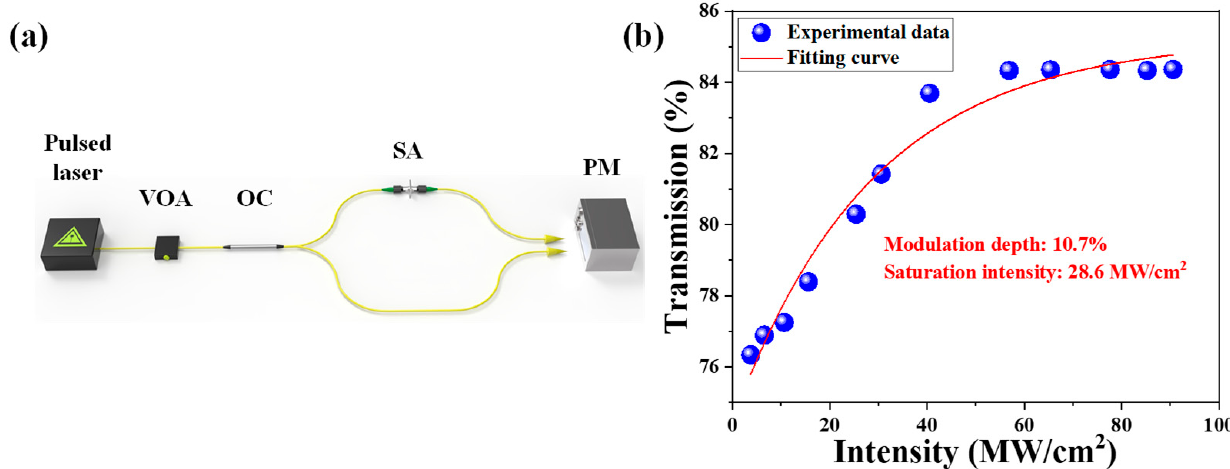
Figure 3. Nonlinear saturable absorption property of the Cr 2 Si 2 Te 6 -based SA. ( a ) The testing setup, ( b ) fitting curve.